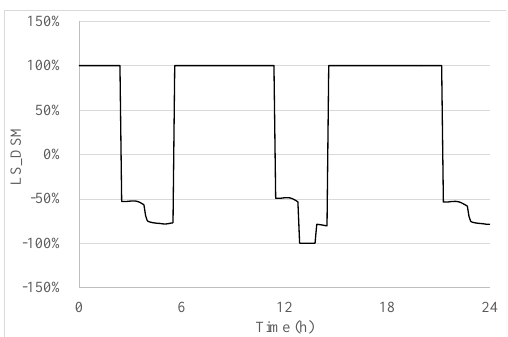
Figure 5. Load shifting indicator ( LS DSM,t ) for a typical winter’s day: comparison between the two configurations with (variable capacity HP) and without demand side management (DSM) (ON-OFF HP).